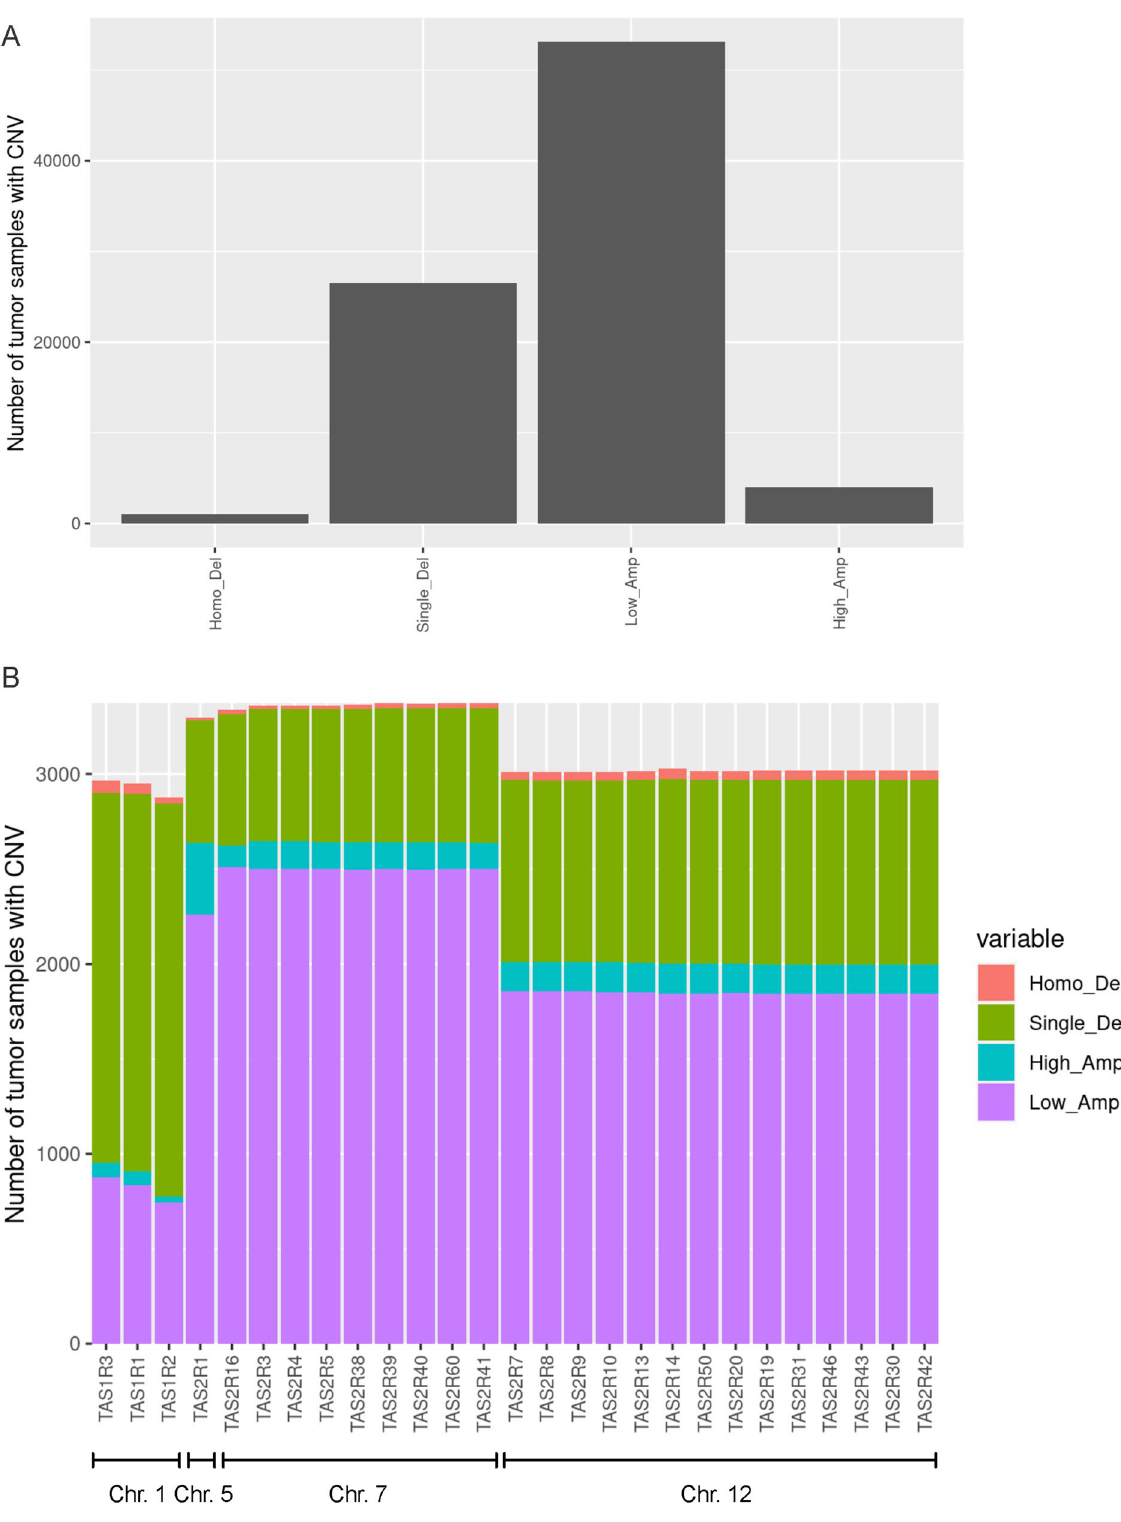
Figure 4. Copy number variation (CNV) in TAS1R and TAS2R genes in solid tumors. ( A – B ) Graphical representations of CNV in TAS1R and TAS2R genes for 20 tumor types (n = 7545) including the total number of homozygous deletions, single-copy deletions, low-level amplifications, and high-level amplifications. Data is shown for ( A ) all TAS1R and TAS2R genes and for ( B ) each gene organized by chromosome location. CNV copy number variation; Chr.